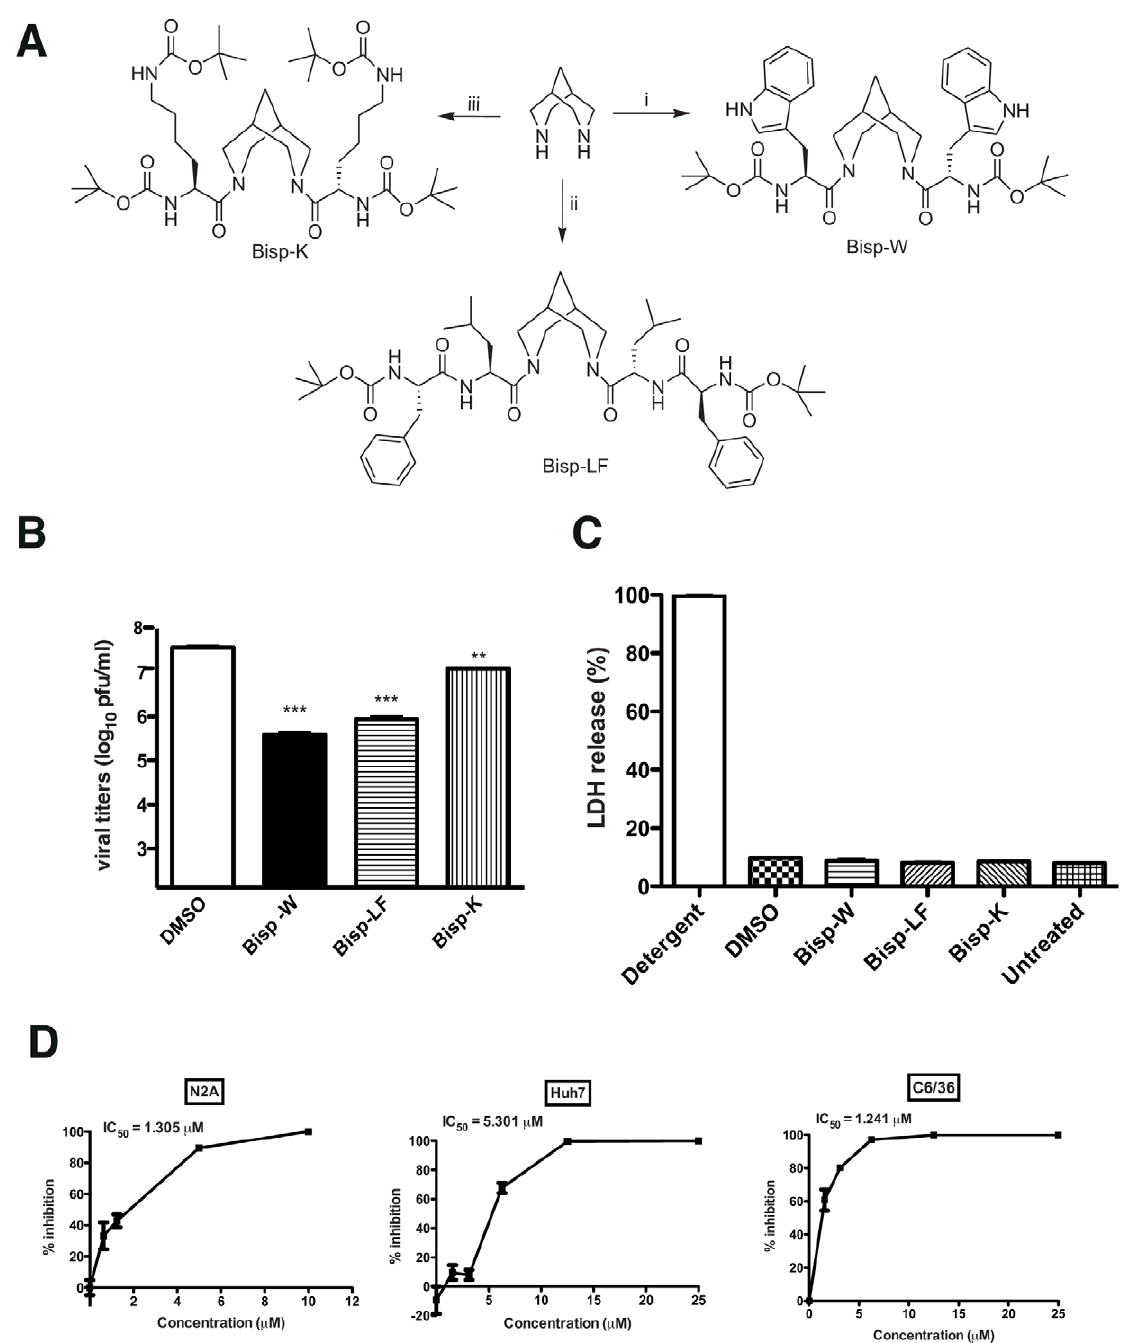
Figure 3. Synthesis of amino acid conjugates of bispidine. (A) Structure of bispidine conjugated with tryptophan (Bisp-W), lecine + phenylalanine (Bisp-LF) and lysine (Bisp-K). (B) Viral titers were determined by plaque assay of N2A cell culture supernatants (22 h pi) infected with JEV and treated with 5 m M of derivatives of bispidine. *** P=0.0004 and 0.0004, ** P=0.0034 and as determined by two-tailed, t-test. Error bars represent Mean 6 SEM of three replicates. (C) Cytotoxicity was measured by lactate dehydrogenase (LDH) assay from culture supernatants treated with 5 m M of the indicated bispidine conjugates or DMSO. LDH released from cells incubated with detergent buffer was used as 100% LDH release. (D) IC 50 value for Bisp-W in the indicated cell lines was estimated by measuring viral titers in cell culture supernatants (22 h pi) infected with JEV and treated with the indicated concentration of Bisp-W. Error bars represent Mean 6 SEM of three replicates. All the data are representative of experiments performed at least twice with three replicates.